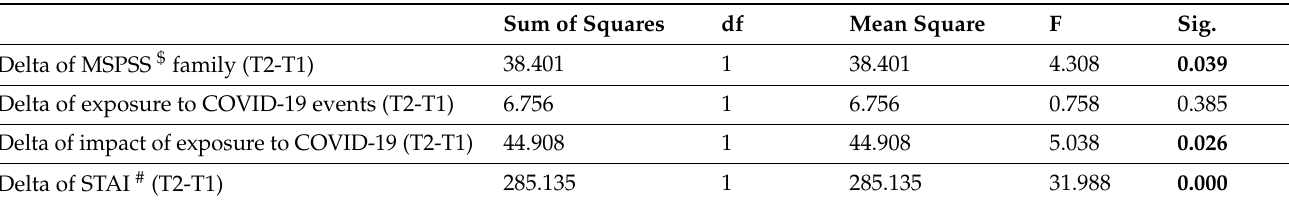
Table 3. Test of within-subjects effect: factors contributing to the changes in the EPDS @ scores between T1 and T2. Sum of Squares df Mean Square F